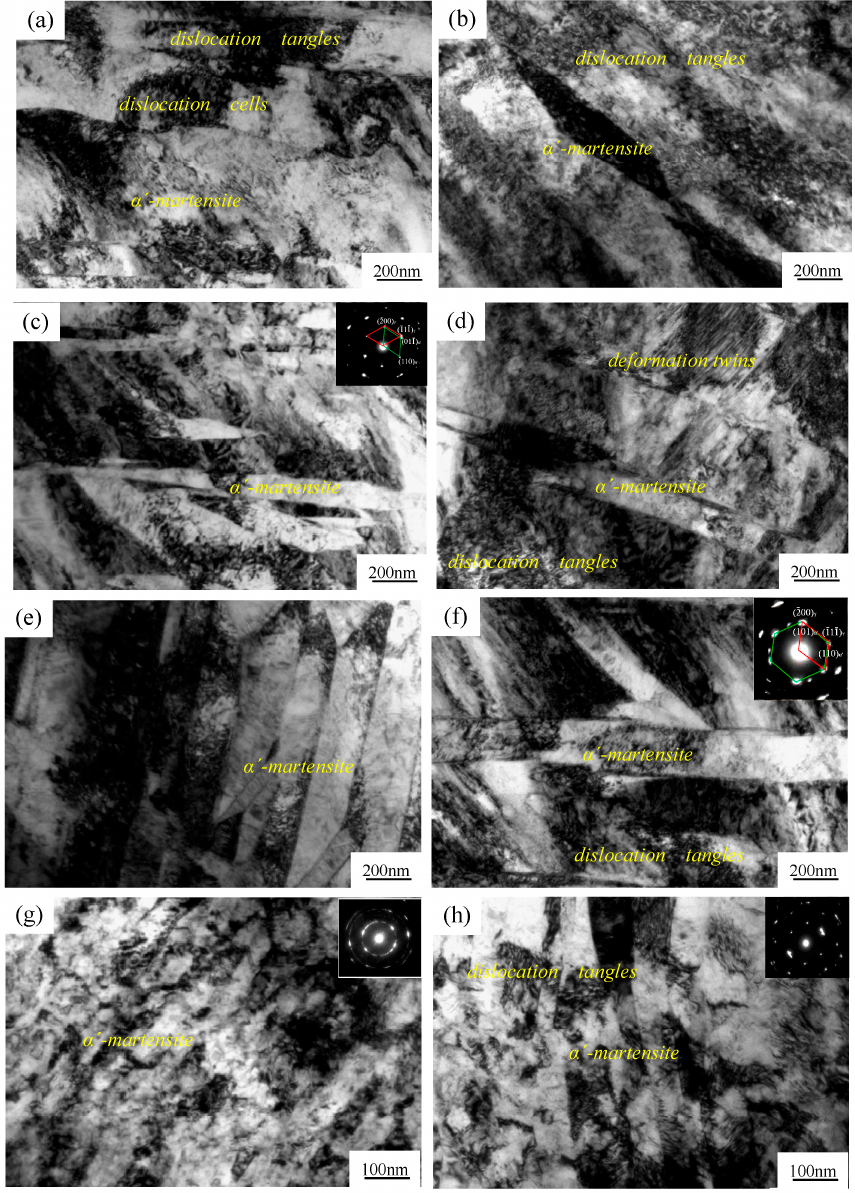
Figure 4. TEM images of the 316LN austenitic stainless steel after CR and RTR: ( a ) CR-30%, ( b ) RTR-30%, ( c ) CR-50%, ( d ) RTR-50%, ( e ) CR-70%, ( f ) RTR-70%, ( g ) CR-90%, and ( h ) RTR-90%.